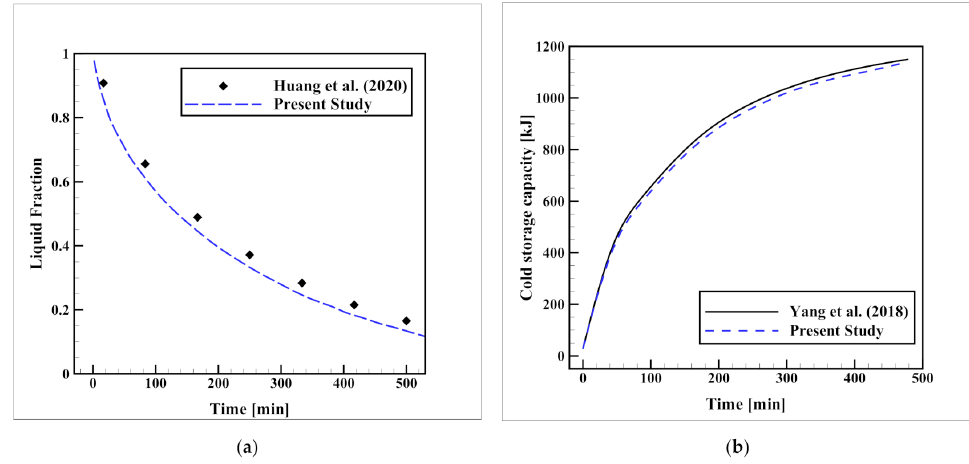
Figure 3. Validation of the CFD method with ( a ) the experimental results from the study of Huang et al. [37], and ( b ) the numerical data of Yang et al.